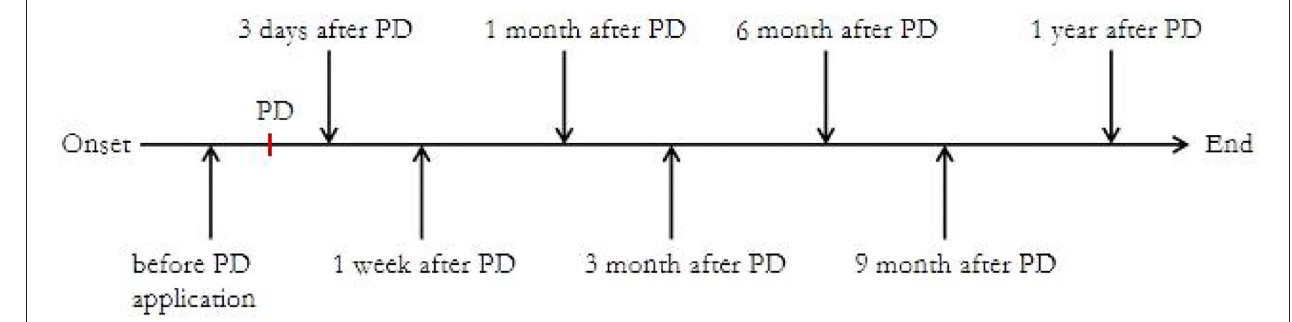
FIGURE 1 | Sample collection flow chart. PD,